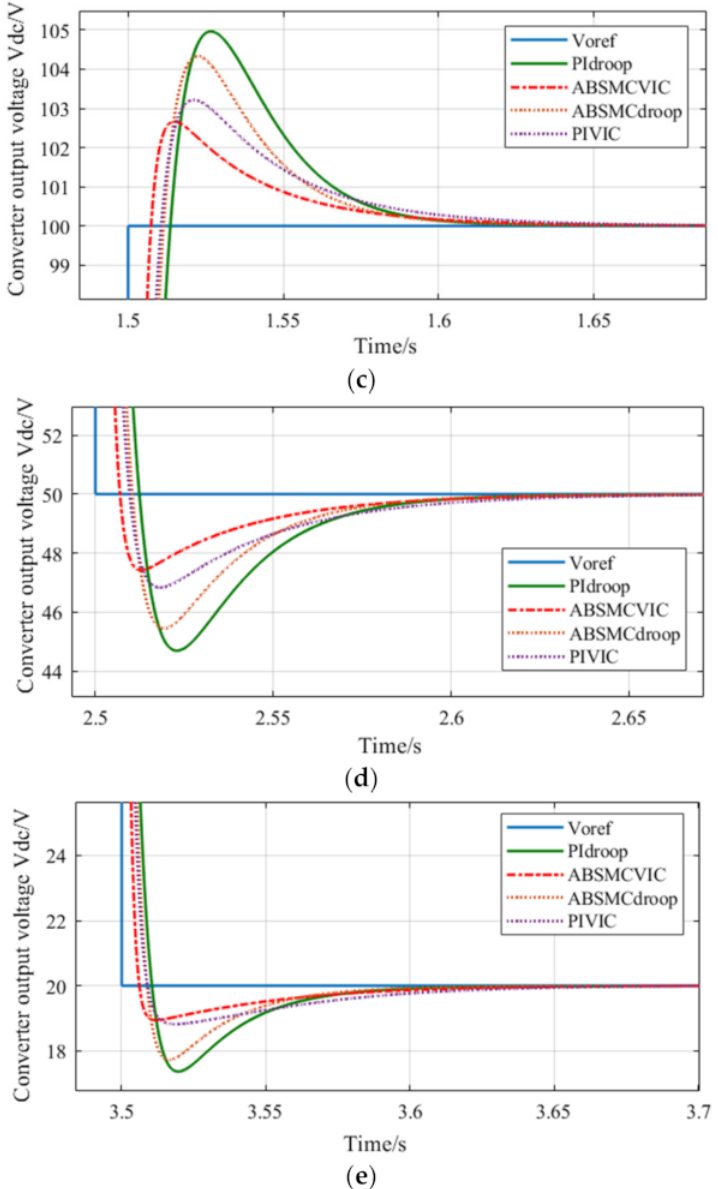
Figure 8. Output voltage response based on three-level cascade control. ( a ) Converter output voltage